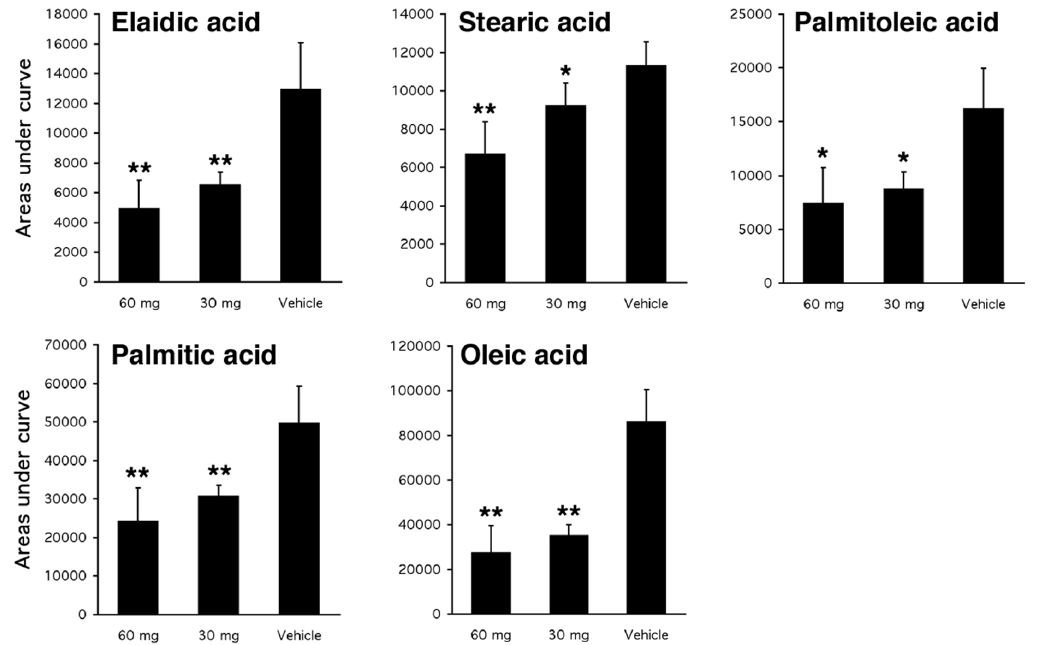
Figure 4. GC-FID analysis of FA content. The content of each FA is expressed as the area under curve in the GC-FID from liver samples that were treated with 7-day cerulenin. day of cerulenin (p , 0.05) and 2.48 6 0.20 m m with 30 mg/kg/day of cerulenin (Fig. 3H) .